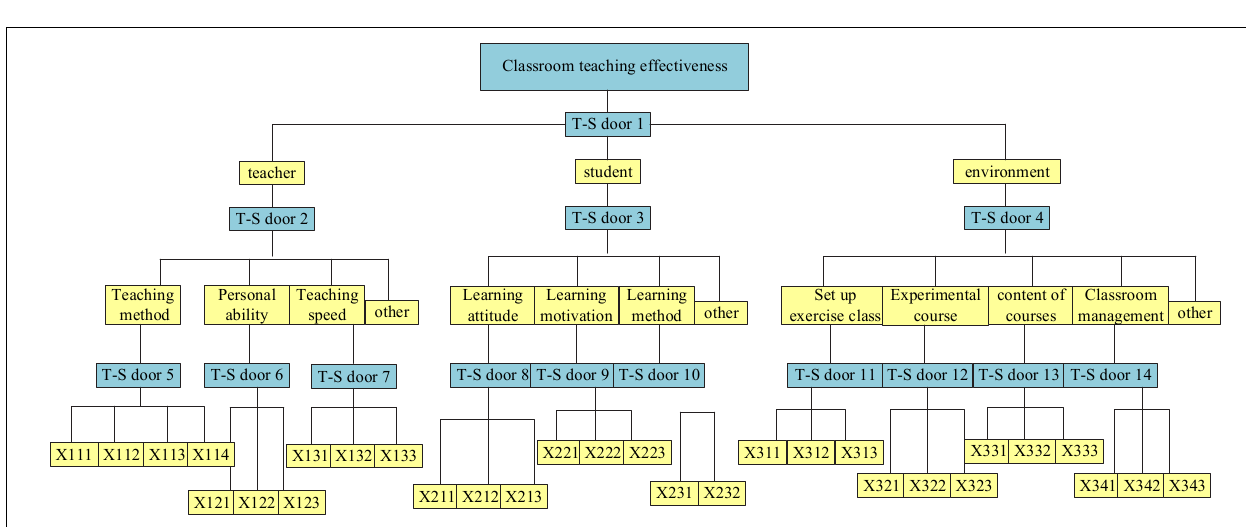
FIGURE 15 | Fuzzy fault tree of classroom teaching effect.